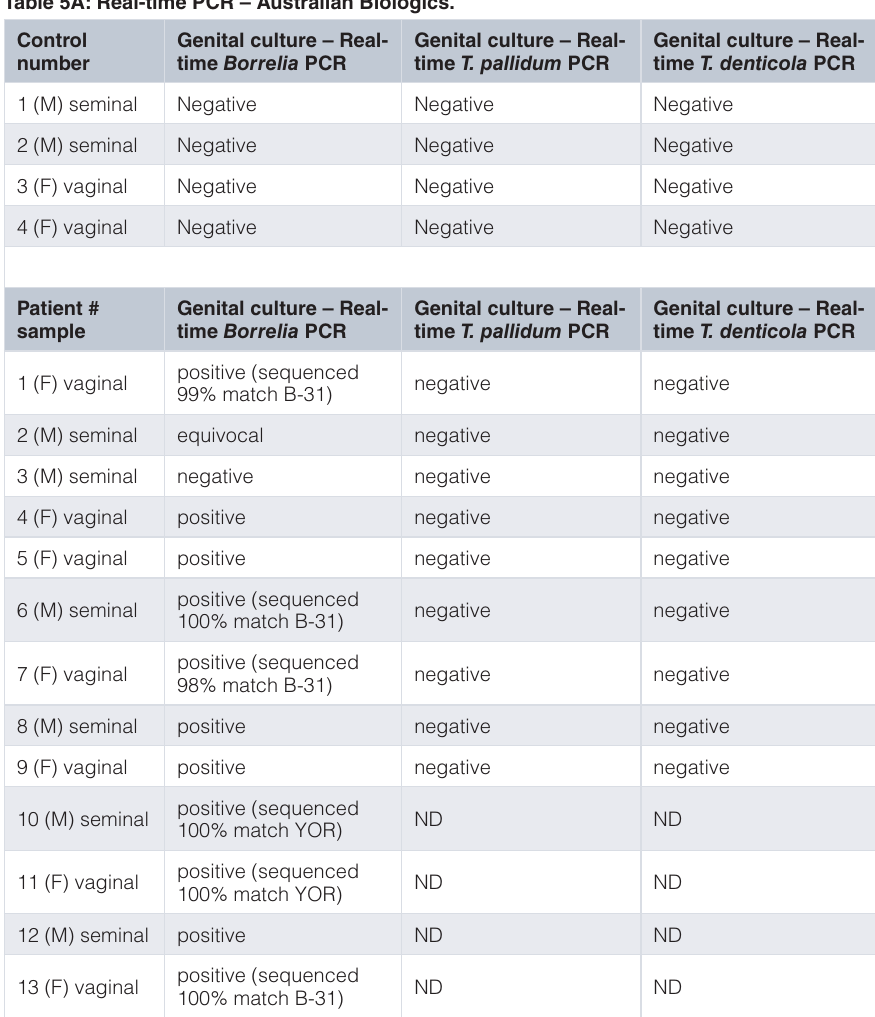
Table 5. A: Real time PCR testing of genital culture concentrates performed by Australian Biologics. ND, not done. See Dataset, data file 5. B: Real time and nested PCR testing of